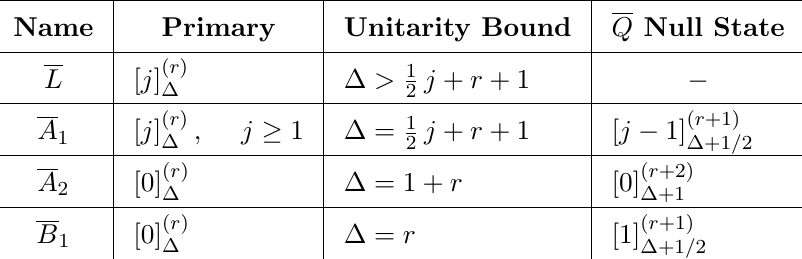
Table 3 . Q shortening conditions in three-dimensional N = 2